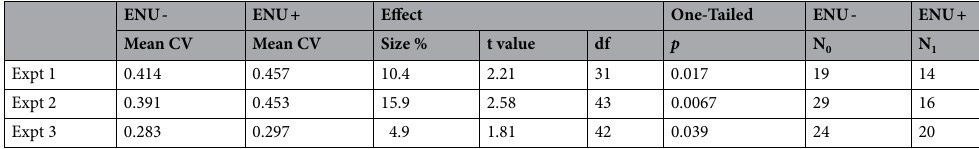
Table 1. Variability of VCL within ejaculates differs significantly between ENU treated males and control males. N 0 and N 1 are sample